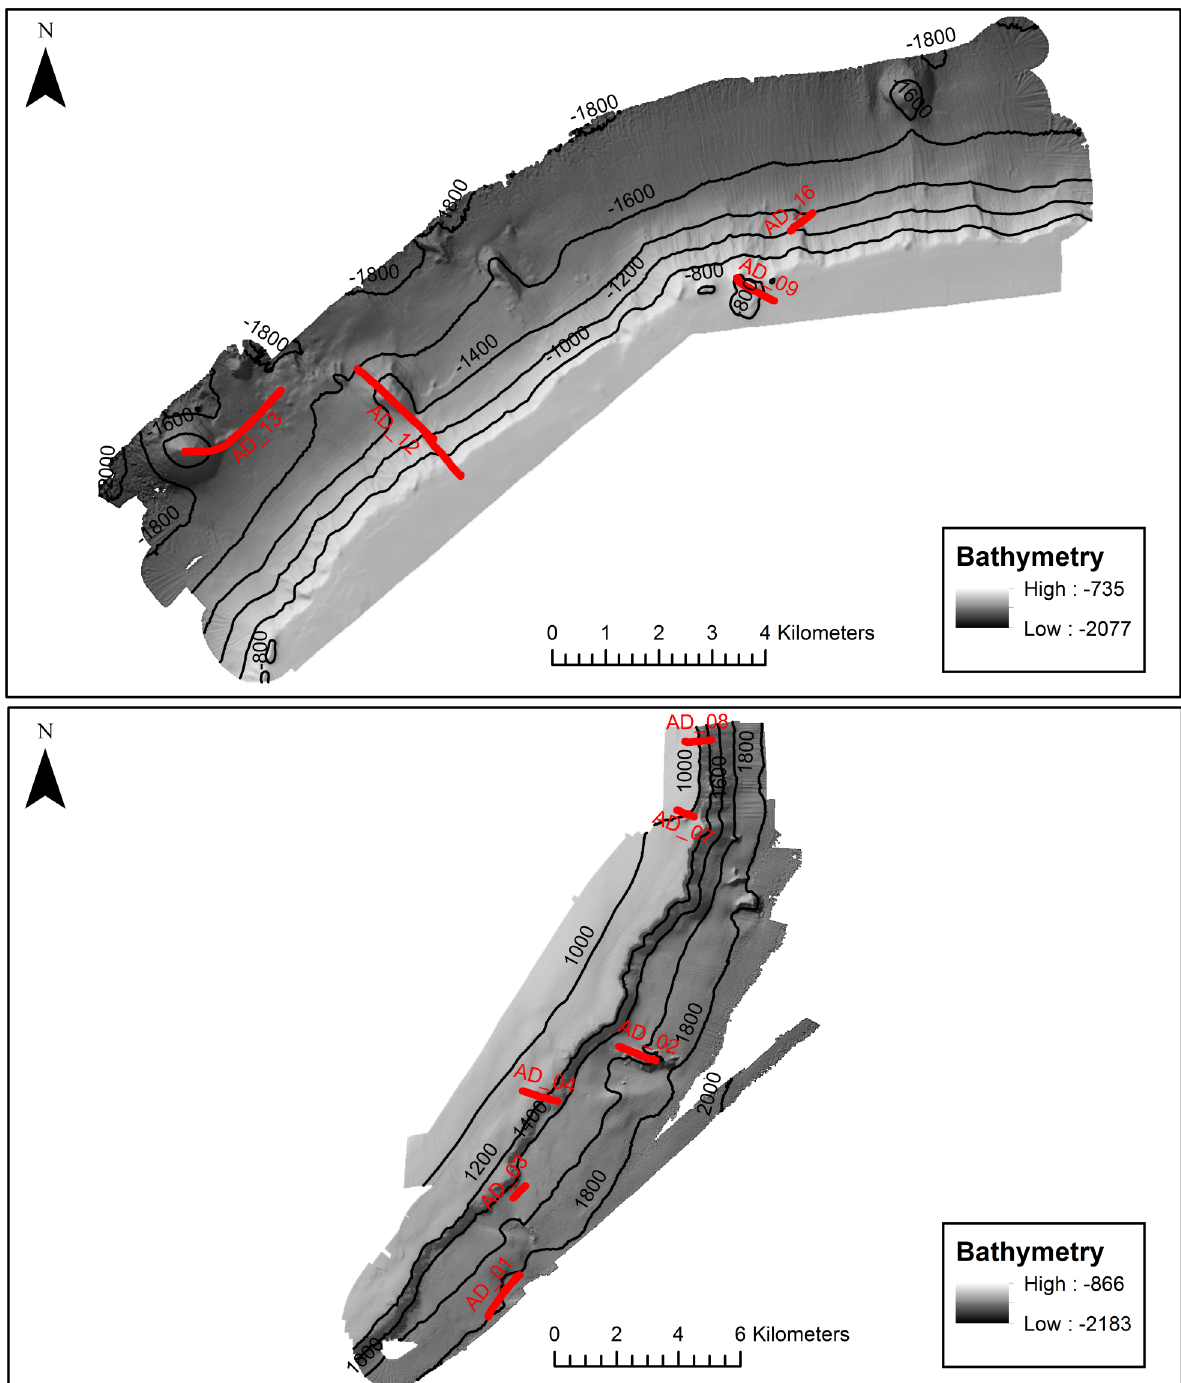
Fig 2. Camera transects sampled from the NW (top) and SE (bottom) survey areas of Anton Dohrn Seamount overlaid on multibeam bathymetry. Selected bathymetric contours are shown as dashed lines with labelled water depths in metres below sea